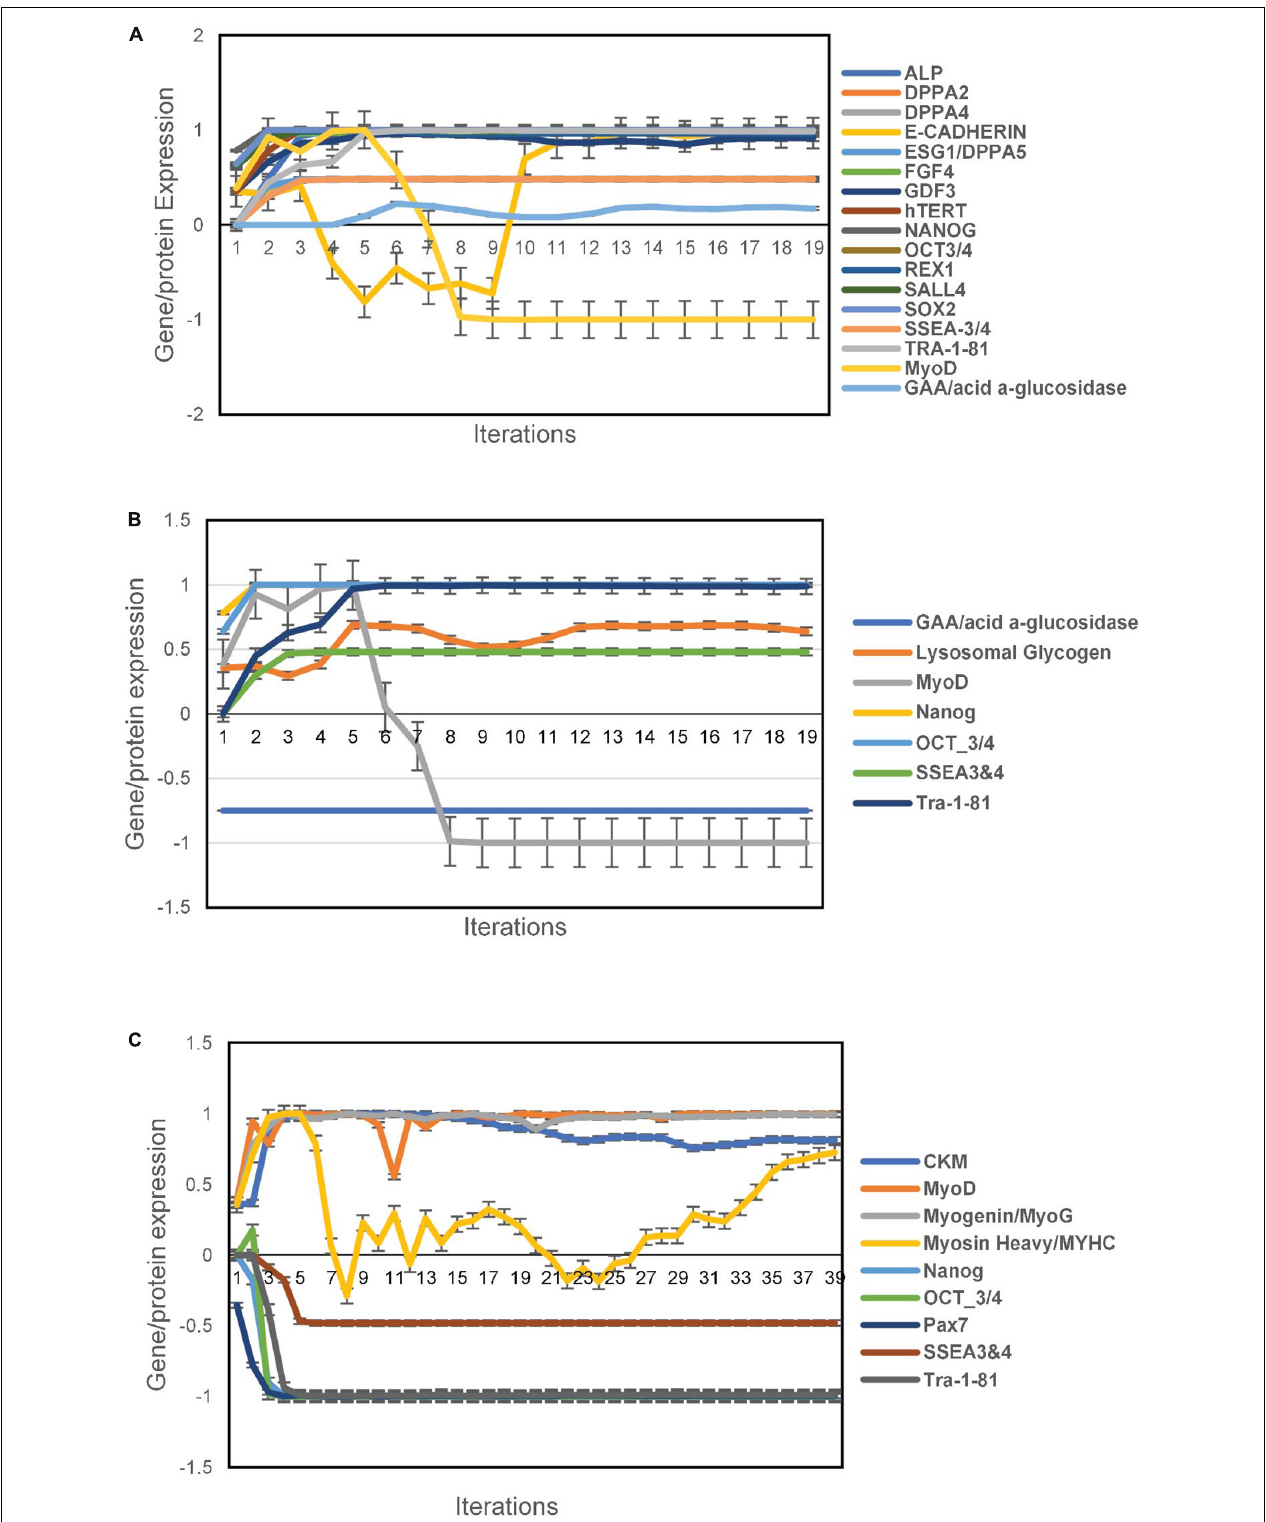
FIGURE 1 | Pluripotency predictions for aiPSC and wild type aiSkMC simulations. (A) Gene/protein expression in wild type aiPSC simulation with MyoD1 turned on. (B) Gene/protein expression in aiPSC simulation with GAA loss of function mutation. (C) Loss of pluripotency in differentiated aiSkMC simulation. Data are representative of three independent simulation experiments; e rror bars indicate ± SEM.